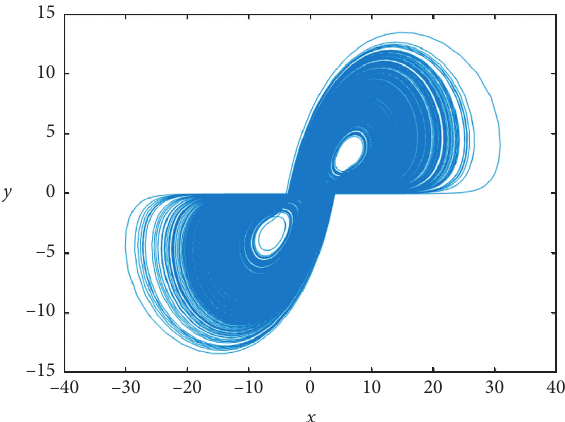
Figure 12: Dynamics of Lu et al.’s fractional-order system with the order α � 0 . 88, in context of x and y directions.